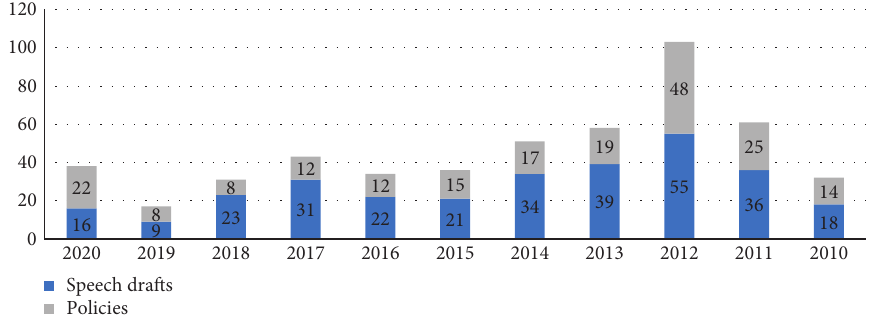
Figure 1: Data on HE speech drafts and policies.